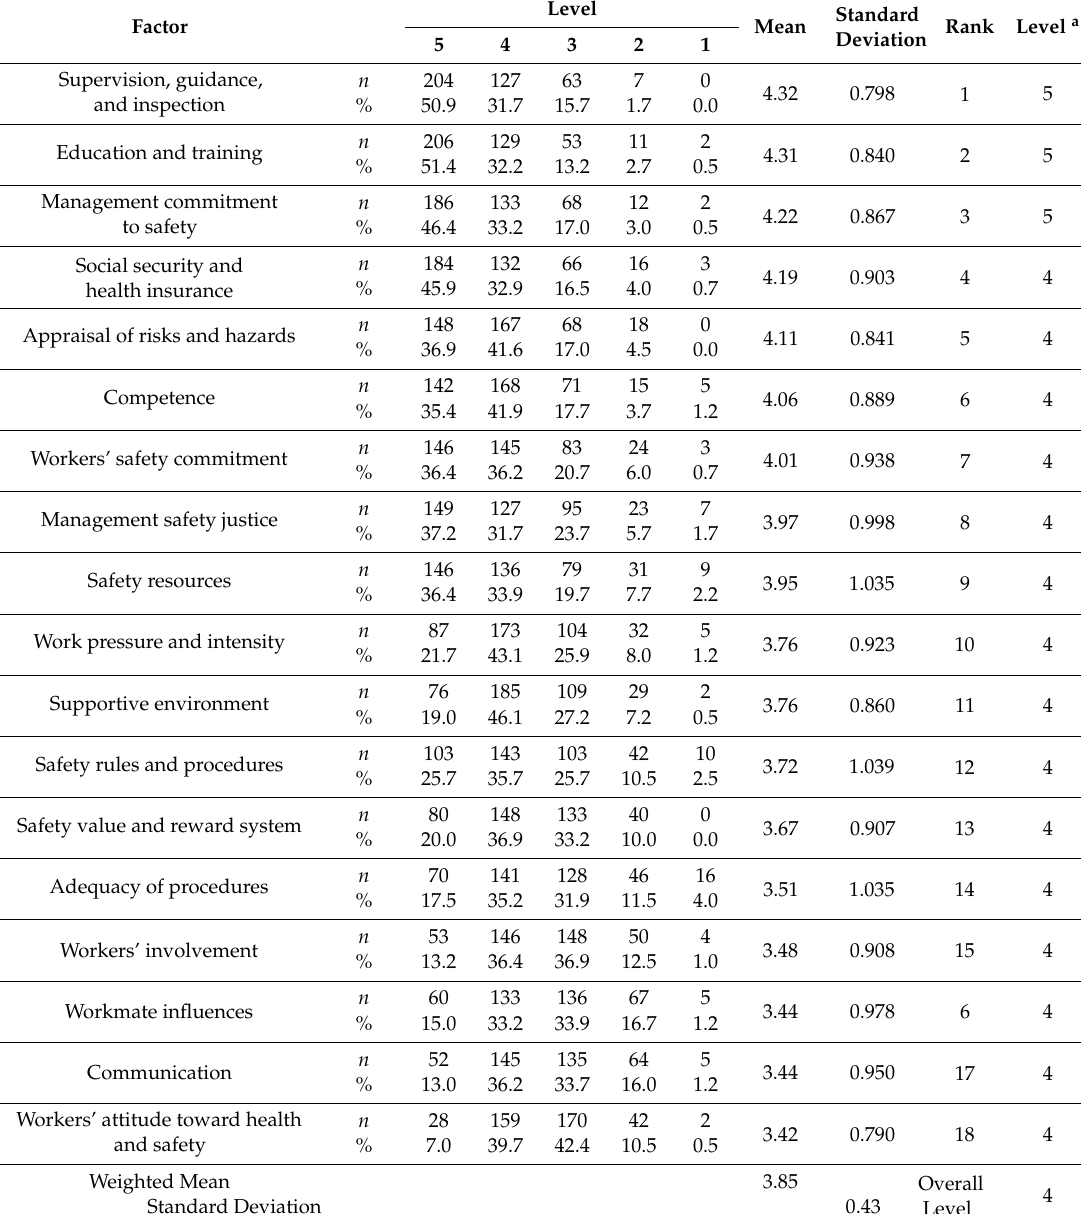
Table 5. Descriptive statistics of factors influencing safety climate ( n = 401).